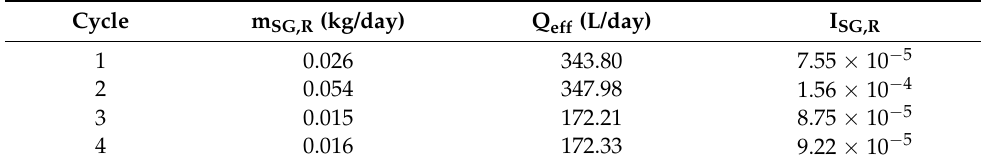
Table 9. Indicator of technological nutrient performance for the recovered sludge.